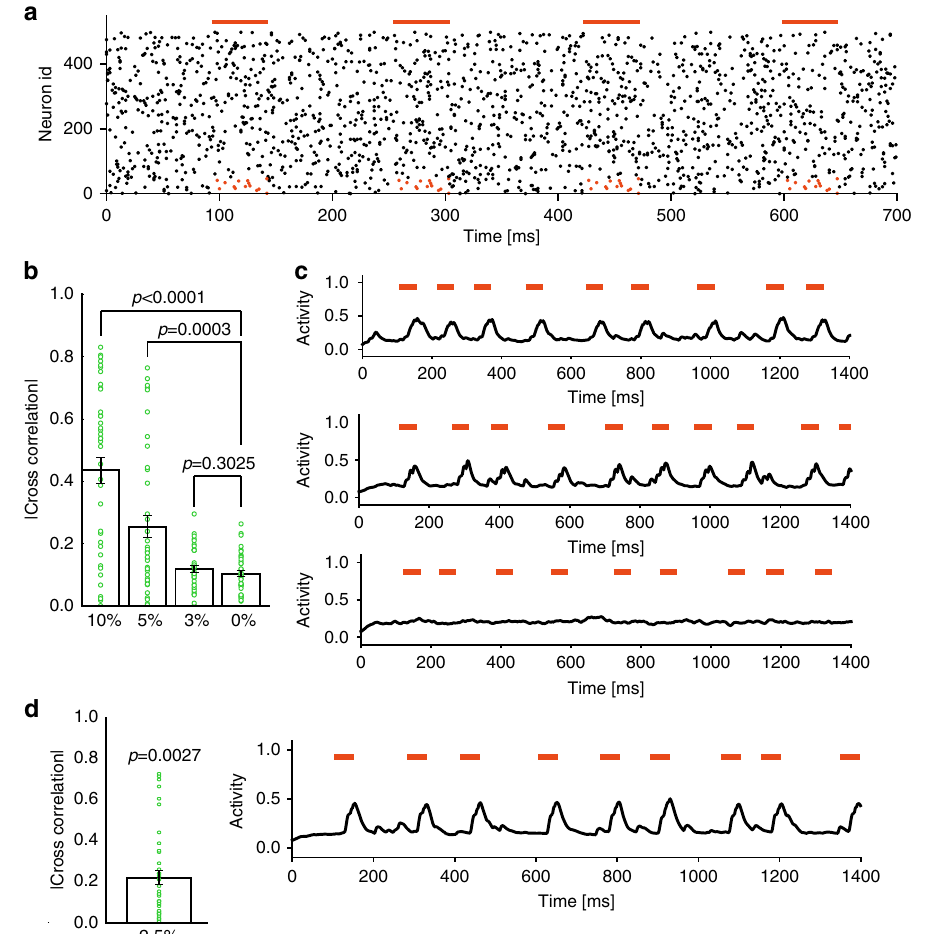
Fig. 3 Detection of cell assembly patterns from neural population data. a Spike sequences with a fi xed spatiotemporal pattern (red) of 50 (10%) neurons were repeatedly activated (red horizontal bars) by Poisson spike trains of 500 presynaptic neurons. Other cases with 25 (5%) and 15 (3%) such neurons were also examined. b Average correlations over 40 independent trials are shown between chunk-selective responses and the corresponding reference patterns. Vertical bars are standard errors and green circles show data points. P -values were calculated by two-sided Welch ’ s t -test. c Examples of chunk- selective neuronal responses in the 10% (top), 5% (middle), and 3% (bottom) cases. d A recurring fi ring pattern of 25 neurons was embedded into input spike trains of 1000 presynaptic neurons. The average and standard error of the input-output correlation with overlaid data points (left) and a typical response after learning (right) are shown. P -value (two-sided Welch ’ s t-test) indicates a signi fi cant difference from the 0% case in b . As in b , 40 independent simulations were